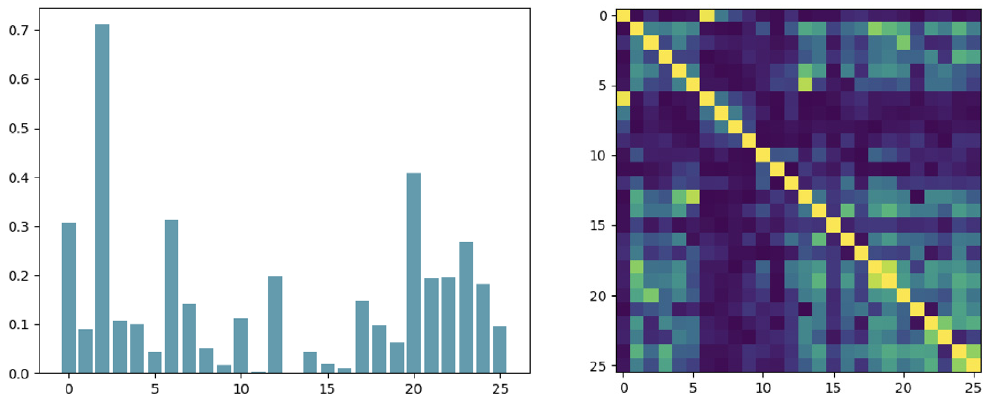
Figure 6. Absolute values of correlation between variables and prices (left) and between variables (right). The brighter cells have higher correlations